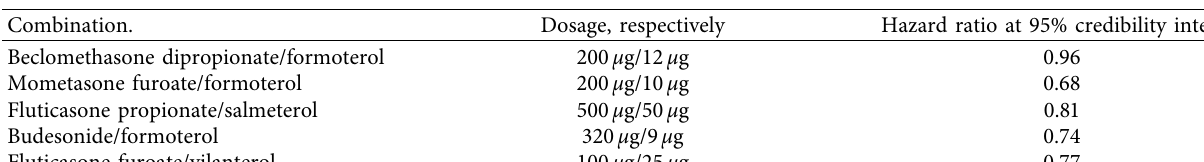
Table 1: Other possible drug combinations used to treat COPD and their pooled effect estimates (LABA on moderate-severe exacerbations) [6].